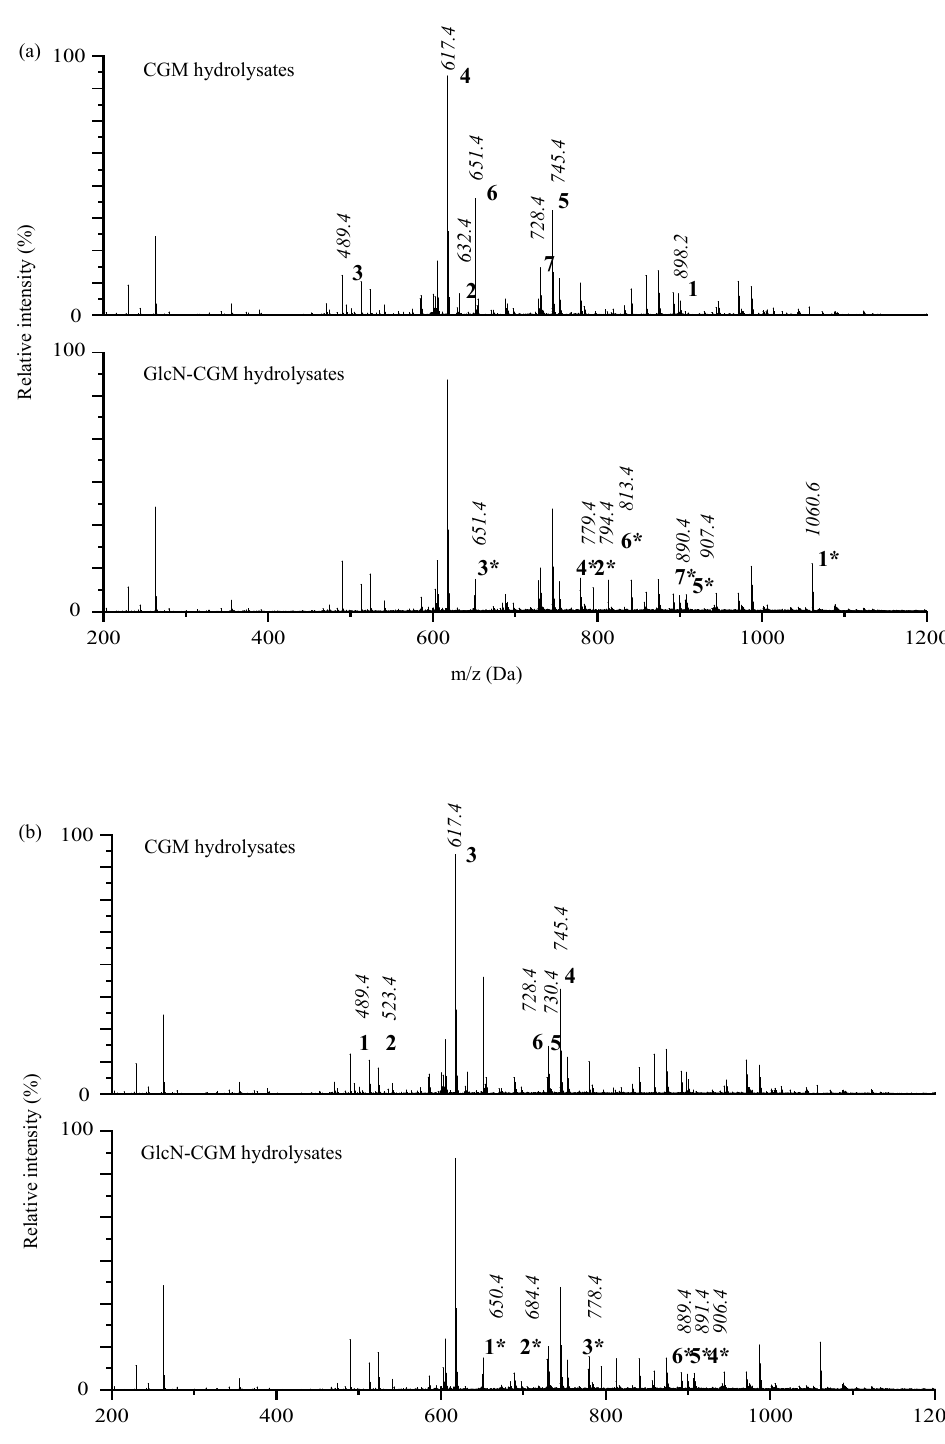
Figure 2. ESI-MS / MS spectra of CGM hydrolysates ( a ) and CGM hydrolysates conjugated with GlcN by TGase at 37 ◦ C ( b ). GlcN-CGM hydrolysates and natural CGM hydrolysates are indicated with the same number.